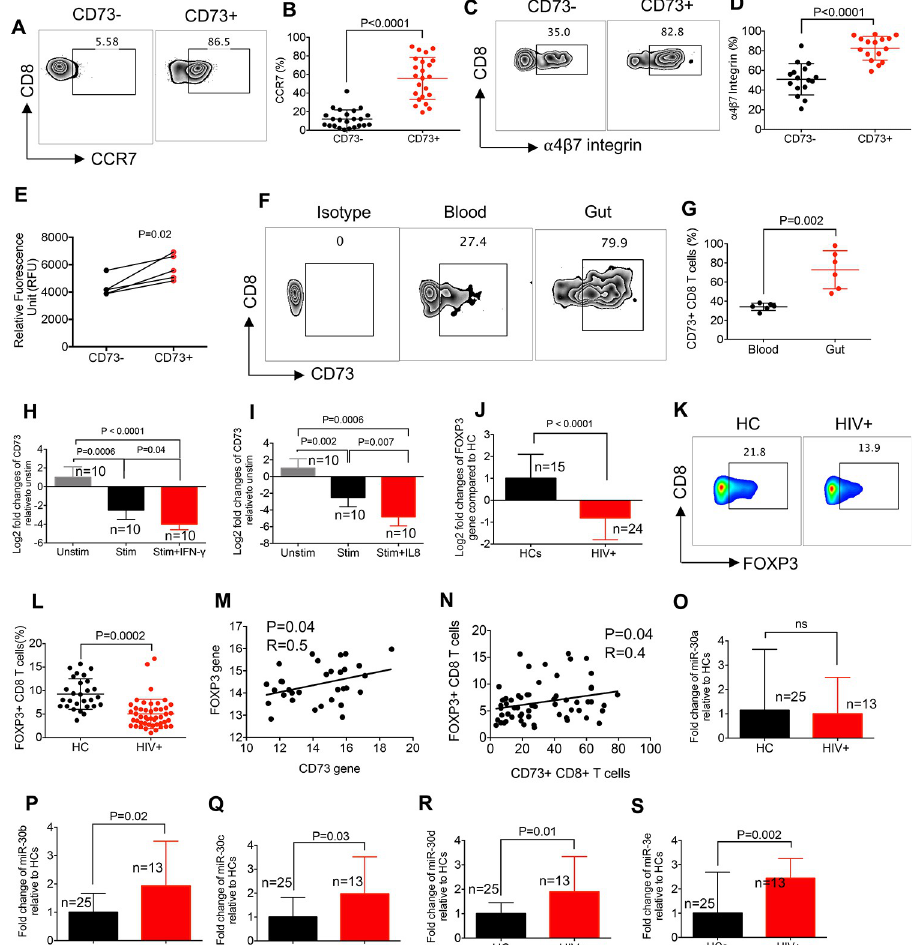
Fig 5. Upregulation of miRNA30b-30e in CD8 + T cells of HIV-infected individuals. ( A ) Representative flow cytometry plots, and ( B ) cumulative data of CCR7 expression on CD73 - versus CD73 + CD8 + T cells. ( C ) Representative flow cytometry plots, and ( D ) cumulative data of α 4 β 7 integrin expression on CD73 - versus CD73 + CD8 + T cells. ( E ) Cumulative results of migratory ability of effector CD8 + CD73 - versus CD8 + CD73 + T cells as measured by RFU. ( F ) Representative flow cytometry plots, and ( G ) cumulative data of the percentage of CD73 expressing CD8 + T cells in the peripheral blood and the gut tissue of mice. ( H ) Fold regulation of CD73 gene in isolated CD8 + T cells either unstimulated (unstim) or stimulated (stim) with anti-CD3/CD28 antibodies in the presence or absence of IFN- γ (100 ng/mL), and ( I ) IL-8 (100 ng/mL). ( J ) Fold regulation of FOXP3 gene in CD8 + T cells isolated from PMBCs of HIV-infected individuals relative to HCs quantified by qPCR. ( K ) Representative flow cytometry plots, and ( L ) cumulative data of FOXP3 expression in CD8 + T cells from HCs vs HIV-infected individuals. ( M ) Cumulative data of the correlation between the CD73 gene and the FOXP3 gene in CD8 + T cells of HIV-infected individuals and HCs. ( N ) Cumulative data of the correlation between the cell surface CD73 and FOXP3 expression in CD8 + T cells of HIV-infected individuals and HCs. ( O ) Fold change of miRNA-30a, ( P ) miRNA-30b, ( Q ) miRNA-30c, ( R ) miRNA-30d, and ( S ) miRNA30-e in CD8 + T cells of HIV-infected individuals relative to HCs quantified by qPCR. Each dot represents data from an individual human subject. Each dot represents data from an individual human subject. Statistical analysis determined by the Mann-Whitney U-test (B, D, E, G, J, L, and O-S), Kruskal–Wallis test (H and I), and by linear regression analysis (M and N) with significance indicated. ns: no significant. “n” reflects the number of